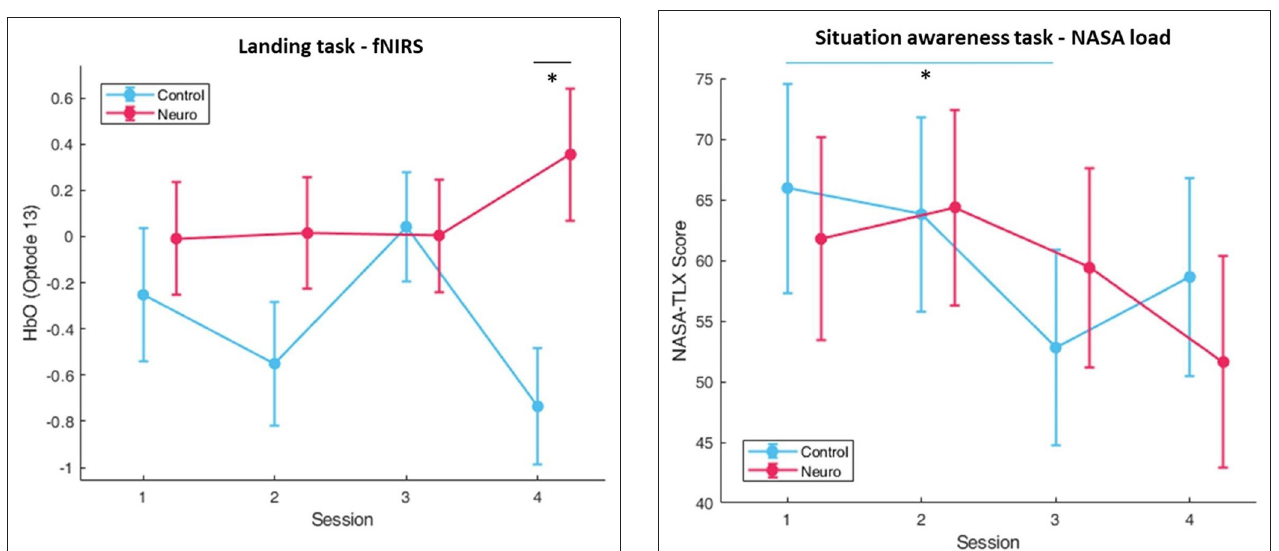
FIGURE 9 | Subjective workload calculated by sum of NASA-TLX self-reports. A significant interaction between condition and session was found (whiskers are SEM, * p <